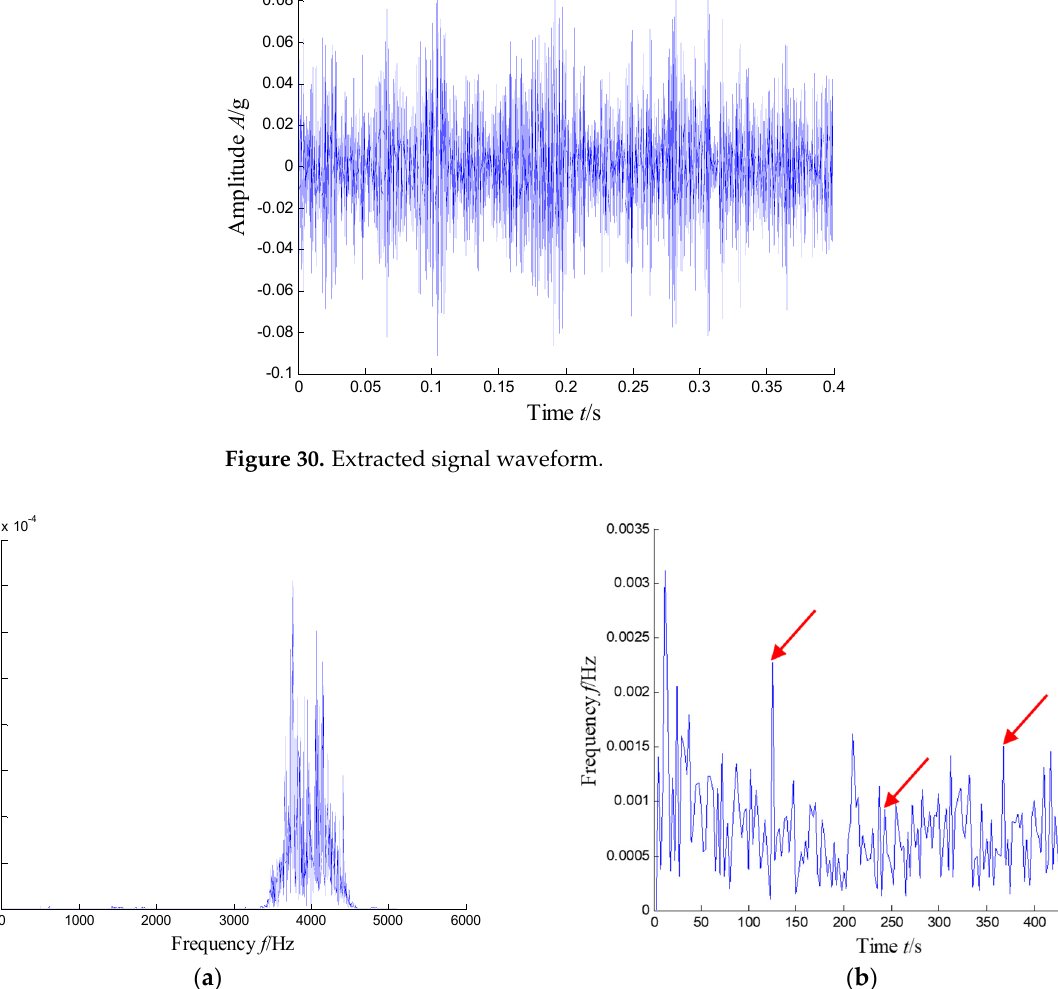
Figure 31. Spectrum and envelop spectrum of the extracted signal: ( a ) spectrum and ( b ) envelope spectrum (the first three order harmonics of f BPFO are highlighted by three red arrows).